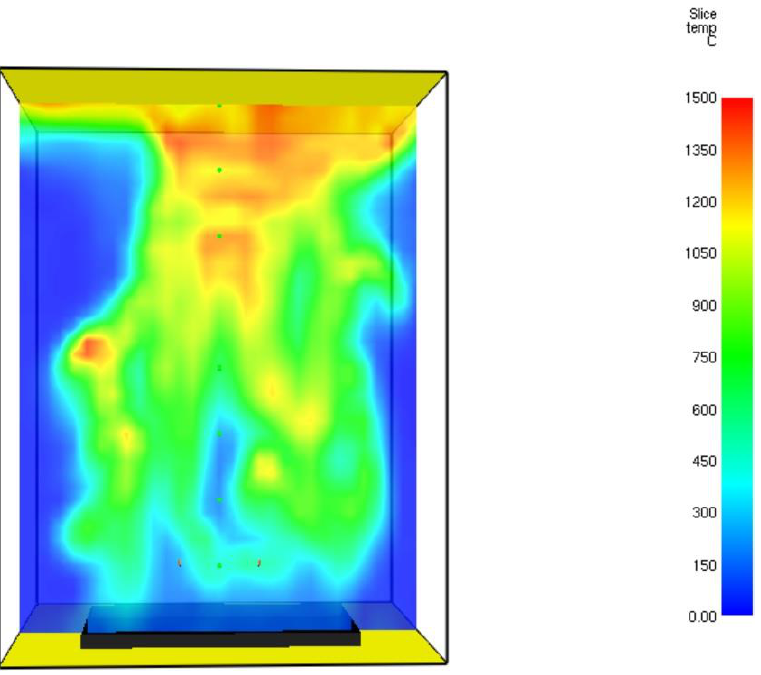
Figure 4. Temperature field ( ◦ C) of the flue gaseous mixture inside the burner at t = 60.7 s. According to Figure 4, the maximal temperature reaches 1440 ◦ C. A similar value was observed in [18]. The calculated temperature at the bottom region of the burner is about 700 ◦ C. Similar to the temperature observed in [23]. Figure 5 shows the velocity field of flue gases at t = 60.7 s.